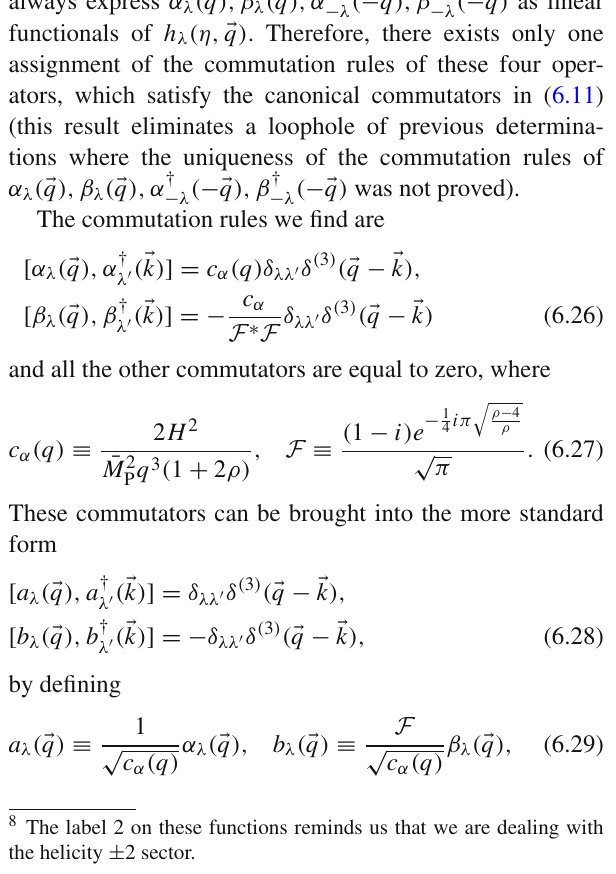
Fig. 1 The Wronskian of the four solutions of the tensor perturbations ondeSitterspace,definedinEq.(6.25)asafunctionoftheratiobetween the Hubble rate and the ghost mass, showing that the solutions are linearly independent. The inset shows the behaviour for H < 2 M 2 with a logarithmic vertical scale. The Wronskian does not depend on z because the fourth order equation (6.15) does not have the term with three derivatives (Liouville